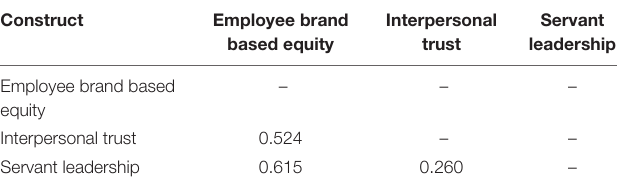
TABLE 3 | Discriminant validity (HTMT).